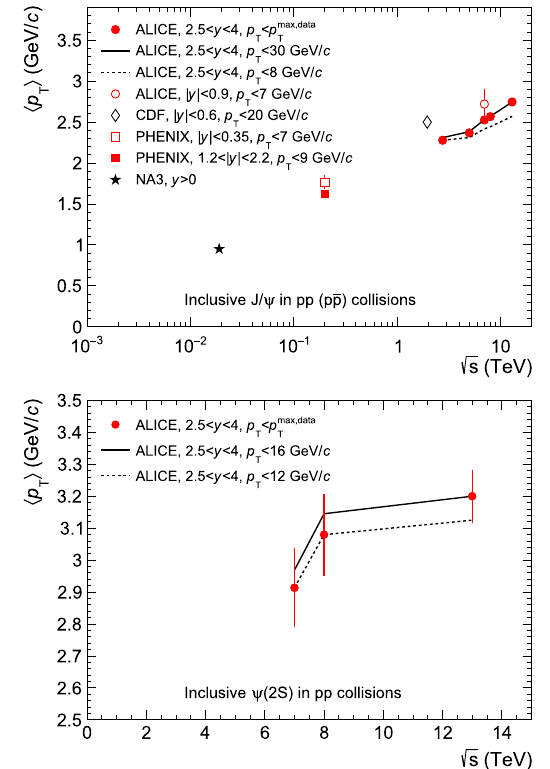
Fig. 5 (cid:3) p t (cid:4) ( left ) and (cid:3) p 2 t (cid:4) ( right ) as a function of and ψ( 2S ) ( bottom ). Circles correspond to ALICE data, while the other symbols correspond to measurements at lower around the data points correspond to the quadratic sum of the statistical and uncorrelated systematic uncertainties. The solid lines correspond